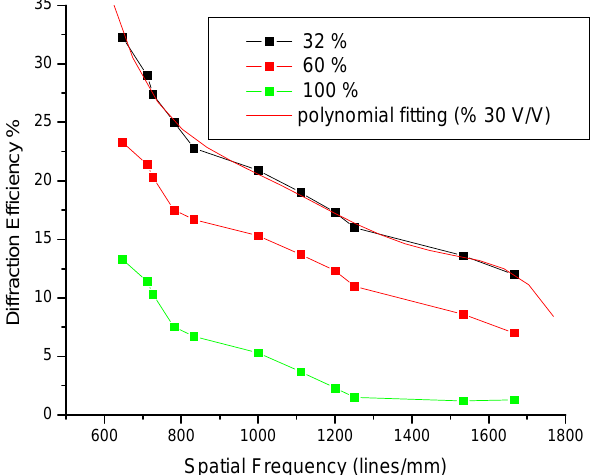
Figure 8. Behavior of a photosensitive polymer based on the nopal cactus extract, as a function of the spatial frequency of the holographic gratings recorded at three different